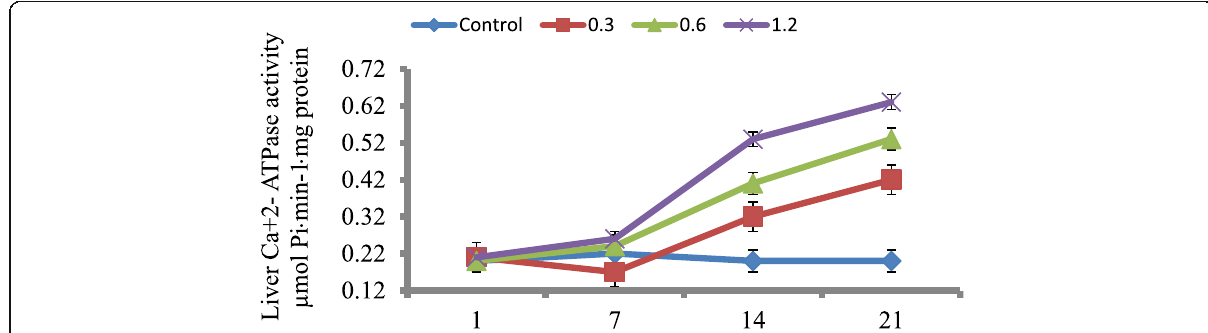
Fig. 3 Changes in the liver Ca 2+ -ATPase activity in Clarias gariepinus juvenile exposed to oxadiazon (mean ±